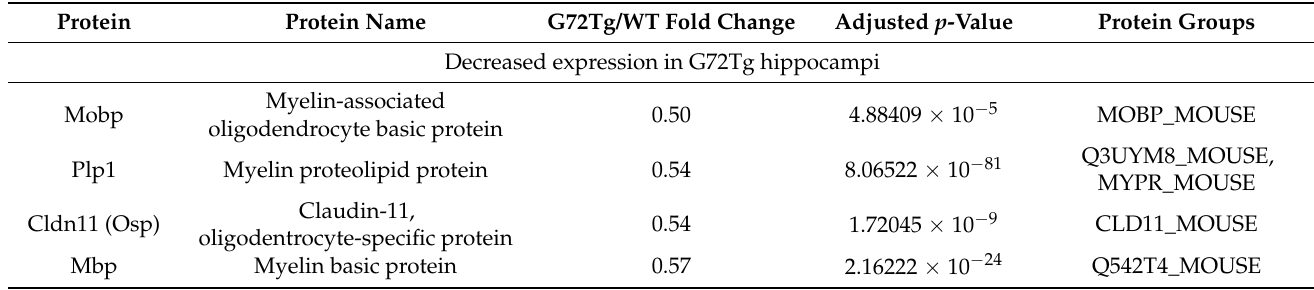
Table 1. Differentially expressed proteins in the hippocampi of G72Tg and WT mice (fold change > 1.3, adjusted p <